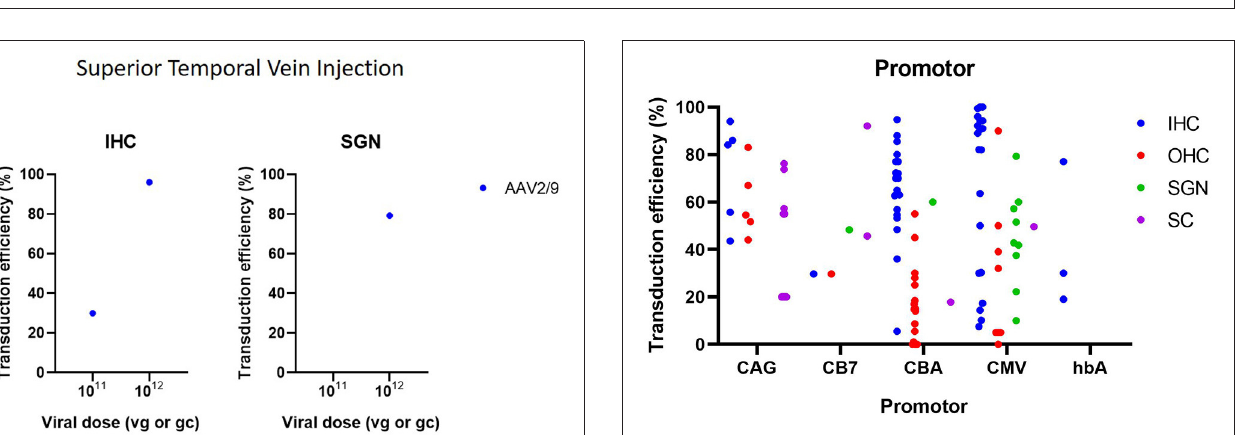
this limitation (Akil et al., 2019b; Al-Moyed et al., 2019; Omichi et al., 2020). As an alternative, LVs and Ads have been used in inner ear gene therapy (Luebke et al., 2009). However,